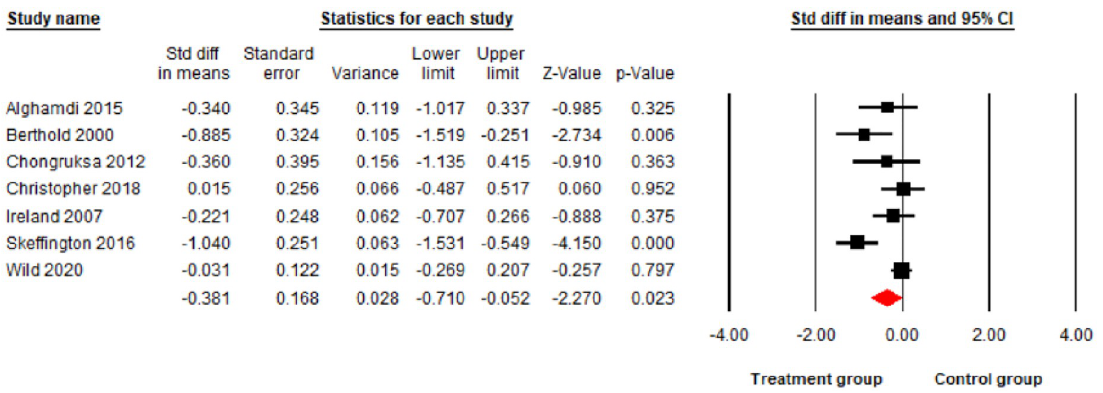
Fig 4. Forest plot for the effect of interventions on anxiety symptoms.